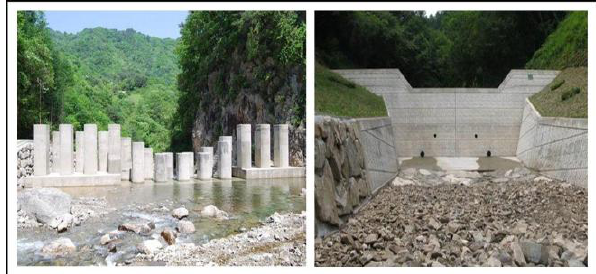
Figure 2. Control structures installed across debris flow